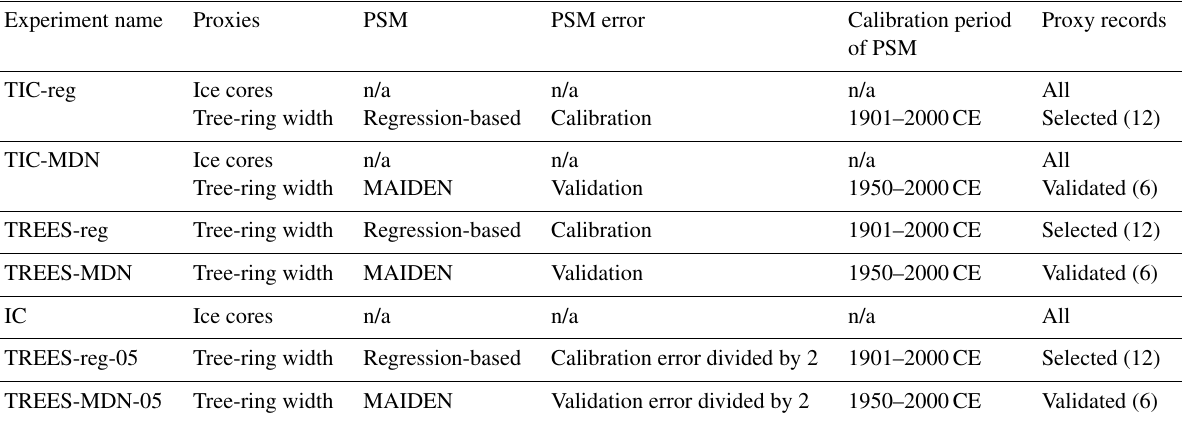
Table 1. Data assimilation experiments in this study and experimental design: experiment name; types of proxies assimilated; proxy system model (PSM) used to assimilate the proxy data; error associated with the PSM; calibration period of the PSM; the proxy records assimilated. The notation n/a stands for not applicable. See Sect. 2.4.1 and 2.4.2 for details on the validated and selected sites, respectively. The number of tree-ring width records assimilated is in